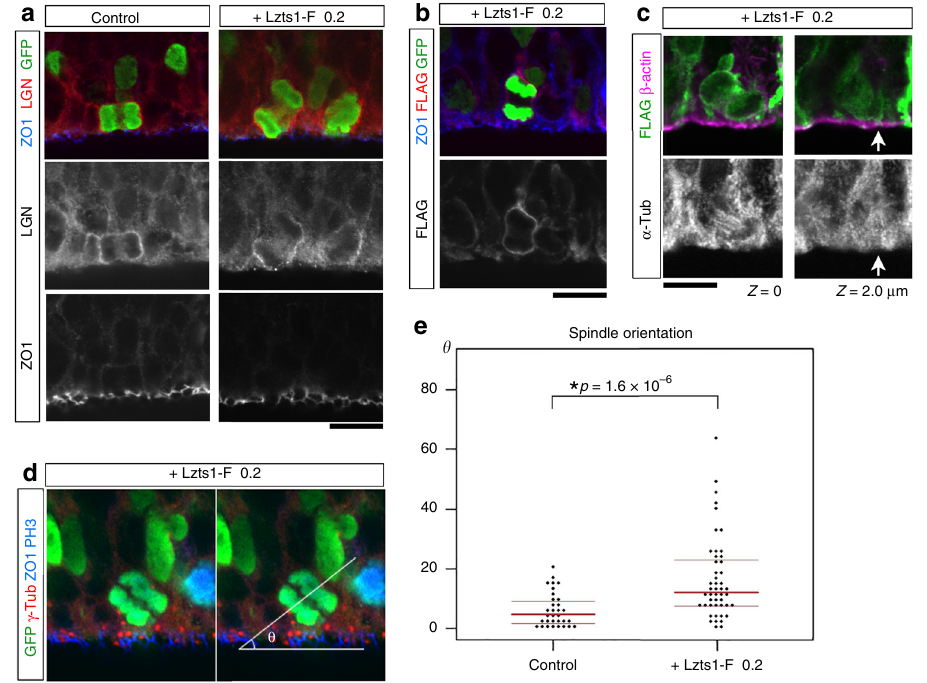
Fig. 8 Low Lzts1 expression gives rise to oblique aRG division. In vivo electroporation was performed at E13 to induce Lzts1 expression at a low level (pCAG::Lzts1-Flag [F]: 0.2 μ g μ l − 1 ) along with H2B-GFP to visualize the DNA, and brain sections were examined at E14. a Triple staining for LGN, ZO1, and GFP in control or Lzts1-F-expressing cells undergoing mitosis at the apical surface. b Triple staining for Flag, ZO1, and GFP in Lzts1-F-expressing cells undergoing mitosis at the apical surface. c Triple immunostaining for α -tubulin, β -actin, and Flag in an Lzts1-F-expressing cell undergoing mitosis. Panels are shown with z = 2.0- μ m intervals. The arrow indicates the connection to the apical surface. d Quadruple staining for GFP, γ -tubulin, ZO1 and PH3. e The number of cells displaying the oblique spindle orientation was signi fi cantly increased following Lzts1-F expression compared with control cells at the apical surface. We measured the spindle orientation θ in fi xed sections d using a 3D-measurement method 39 ( N = 32 and 48 cells from three and four embryos, p = 1.6 × 10 − 6 , Brunner – Munzel test, medians with Q1 and Q3 values are shown) to ensure the accuracy of the